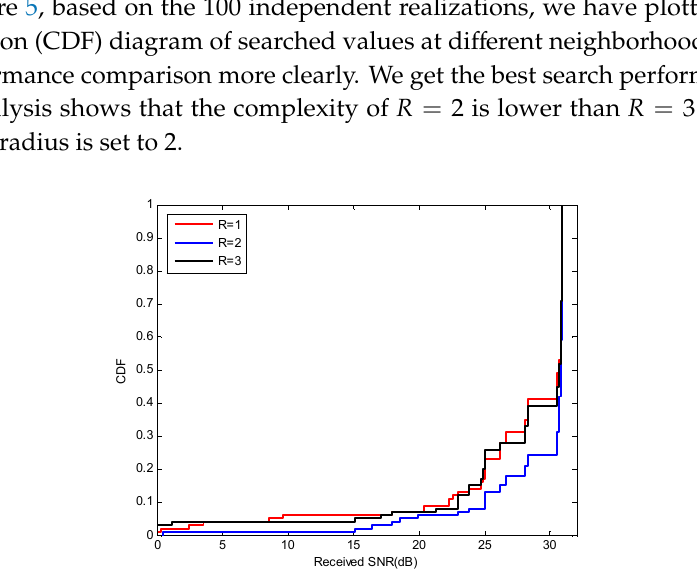
Figure 5. The cumulative distribution function (CDF) diagram of search results at different neighborhood radius.